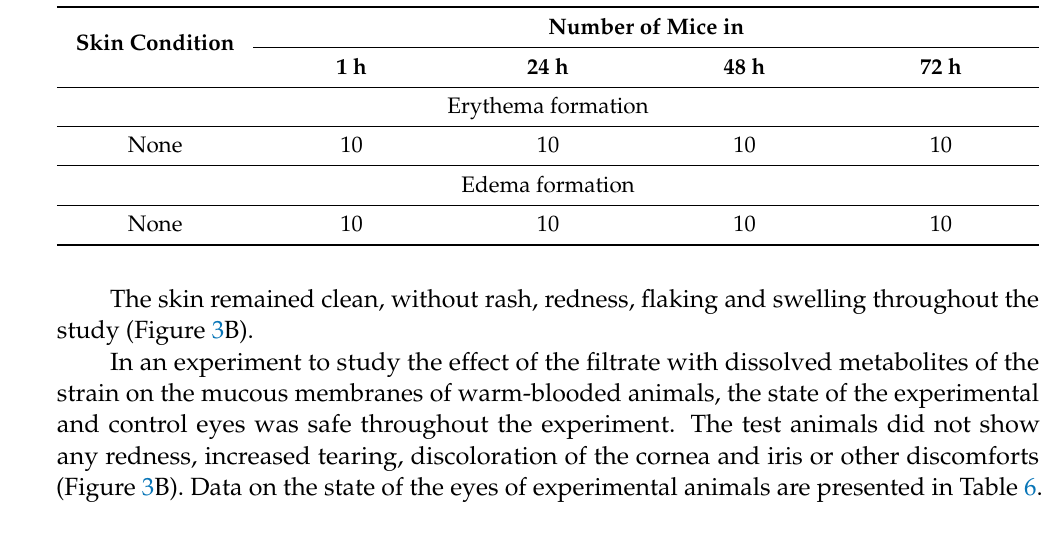
Table 6. Skin condition of experimental